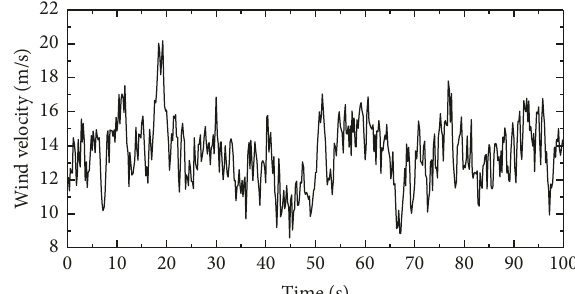
Figure 8: Simulated wind speed time history at the middle-span